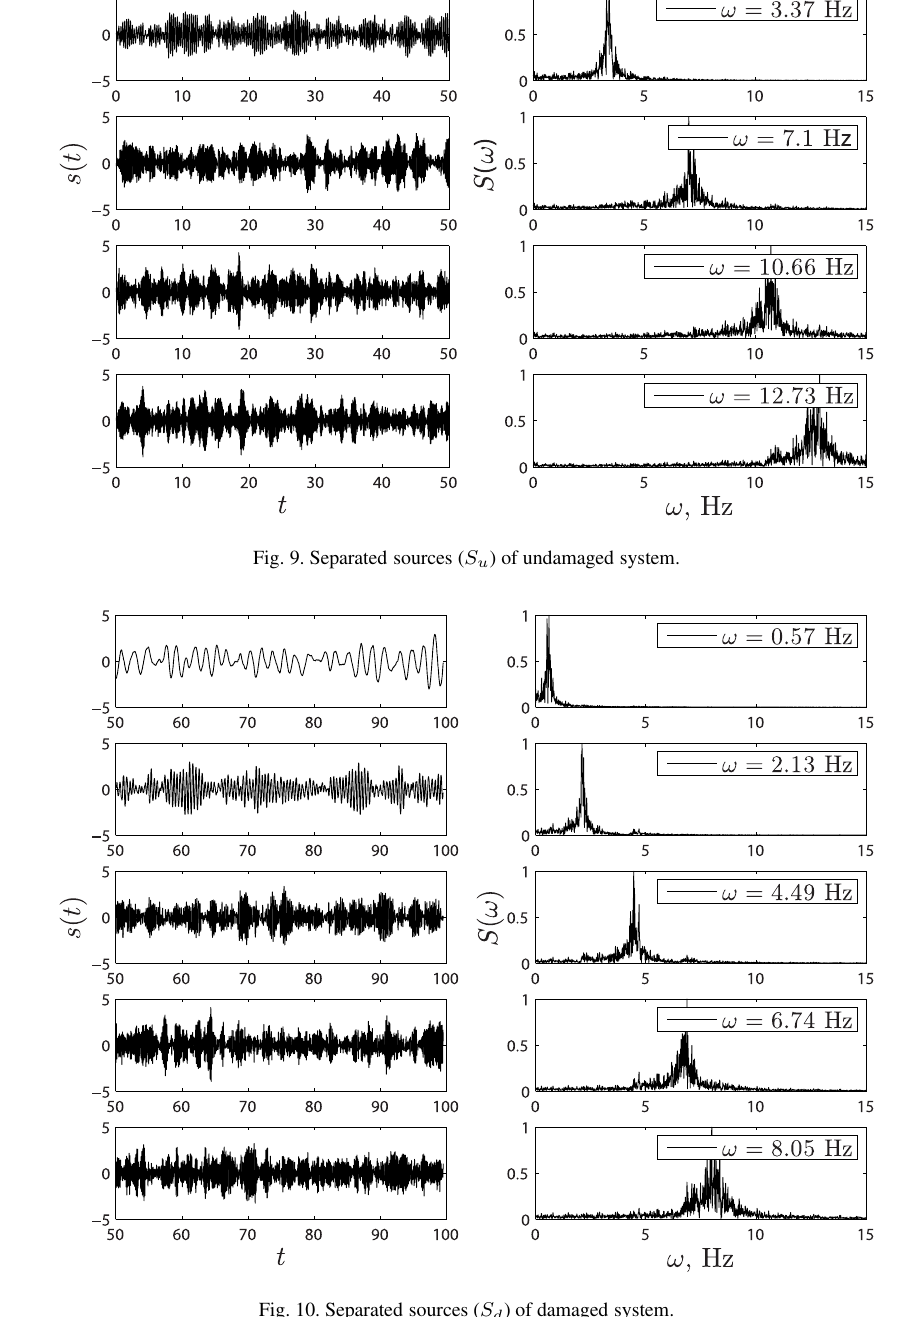
Fig. 10. Separated sources ( S d ) of damaged